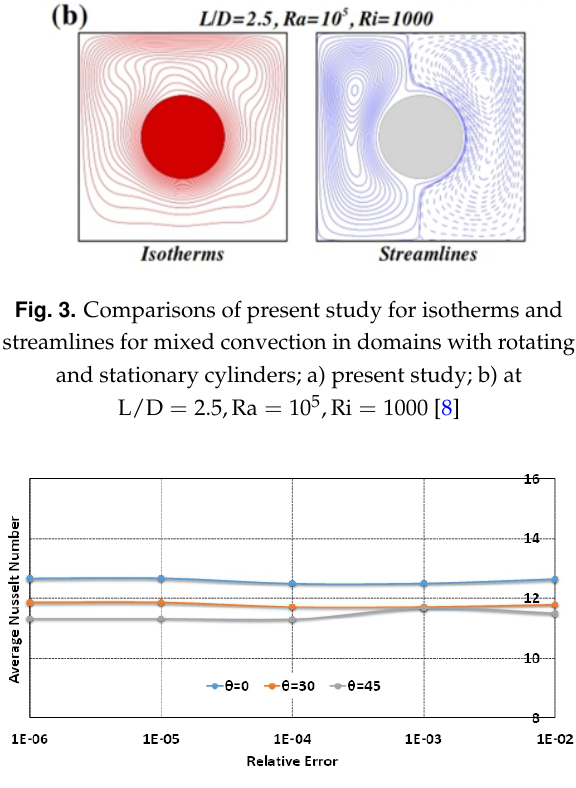
Fig. 4. Average Nu dependency on the imposed accuracy for Ω = 200,C = 0.21 and Ra = 10 6